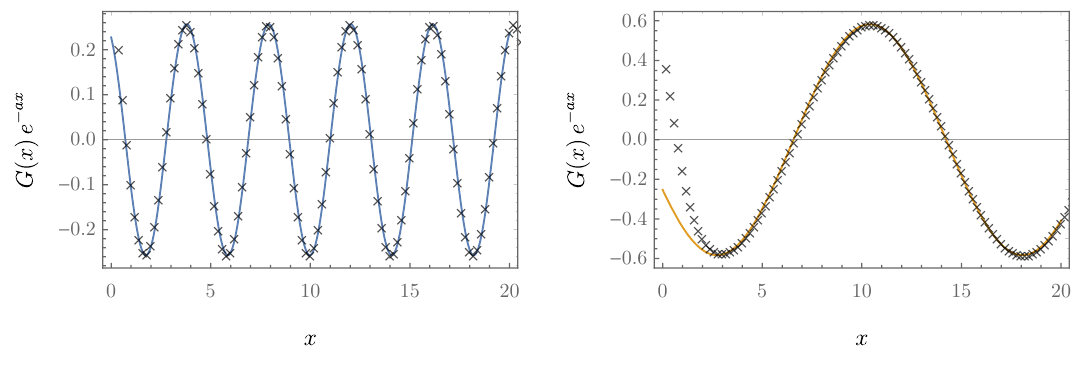
Figure 8 . The approximation of eq. (4.32) for G ( x ) for x (cid:29) 1, divided by e ax (solid line) contrasted with numerical results (crosses). The coe(cid:14)cients a and b were extracted from the poles of g (1 =(cid:17) ) while c and d were (cid:12)tted after dividing the full, numerically evaluated, G ( x ) by e ax . Already for moderate values of x we observe excellent agreement. The singlet exchange is shown on the left and the 27 is on the